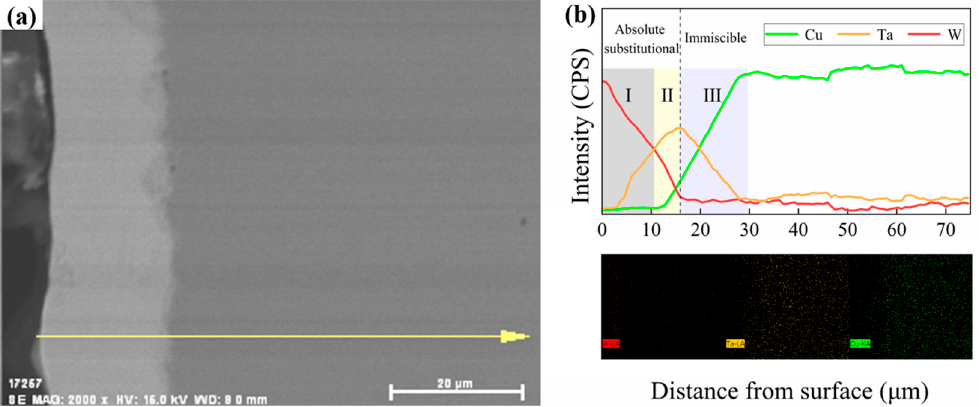
Figure 3. Cross-sectional SEM micrograph and EDS analysis of W/Ta multilayer coating: ( a ) cross-sectional microstructure and ( b ) cross-sectional composition distribution.